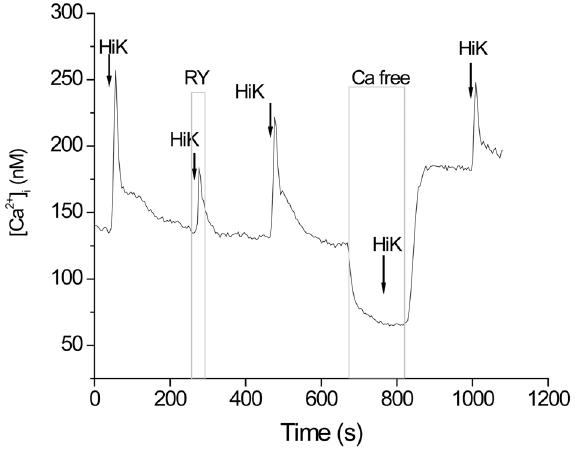
Figure 6. L type voltage-gated calcium channels and RyRs. Representative trace showing the absence of any evoked cytosolic calcium response in an external calcium free solution in a GAD67-GFP taste cell that expresses ryanodine receptors (n=15).